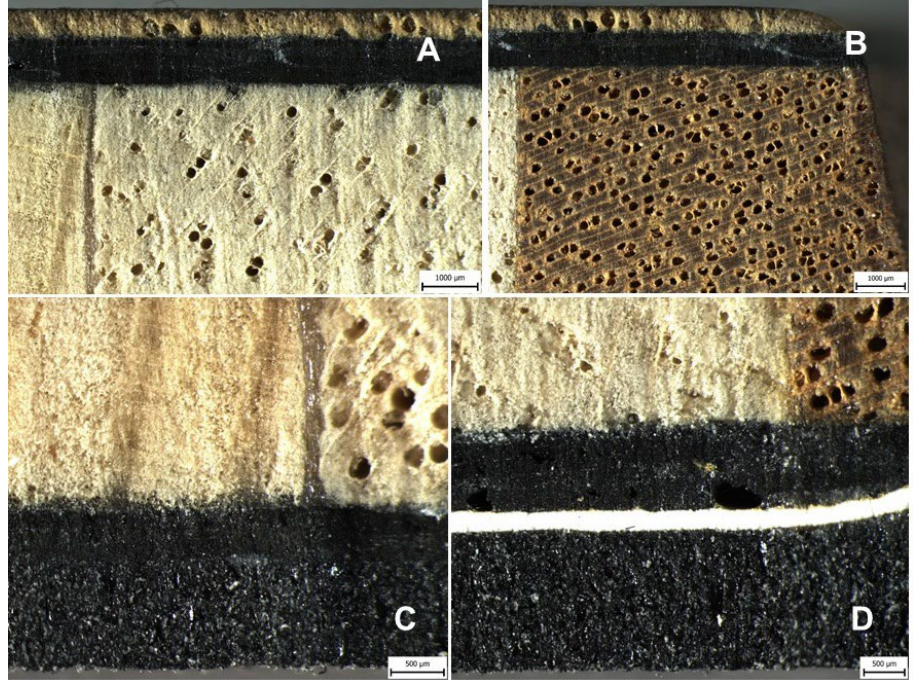
Figure 10. Cross-section of a hybrid sandwich ski structure after long-term low-cycle fatigue, i.e., 70,000 cycles: ( A ): top of ski—material interface wood topsheet (No. 1), E-Glass biaxial (No. 2), carbon triaxial (No. 3), carbon unidirectional (No. 4, 5, 6), E-Glass biaxial (No. 7), wood core (No. 8) (scale 1000 μm ) ; ( B ): side of ski-material interface wood topsheet (No. 1), E-Glass biaxial (No. 2), carbon triaxial (No. 3), carbon unidirectional (No. 4, 5, 6), E-Glass biaxial (No. 7), wood sidewall (No.